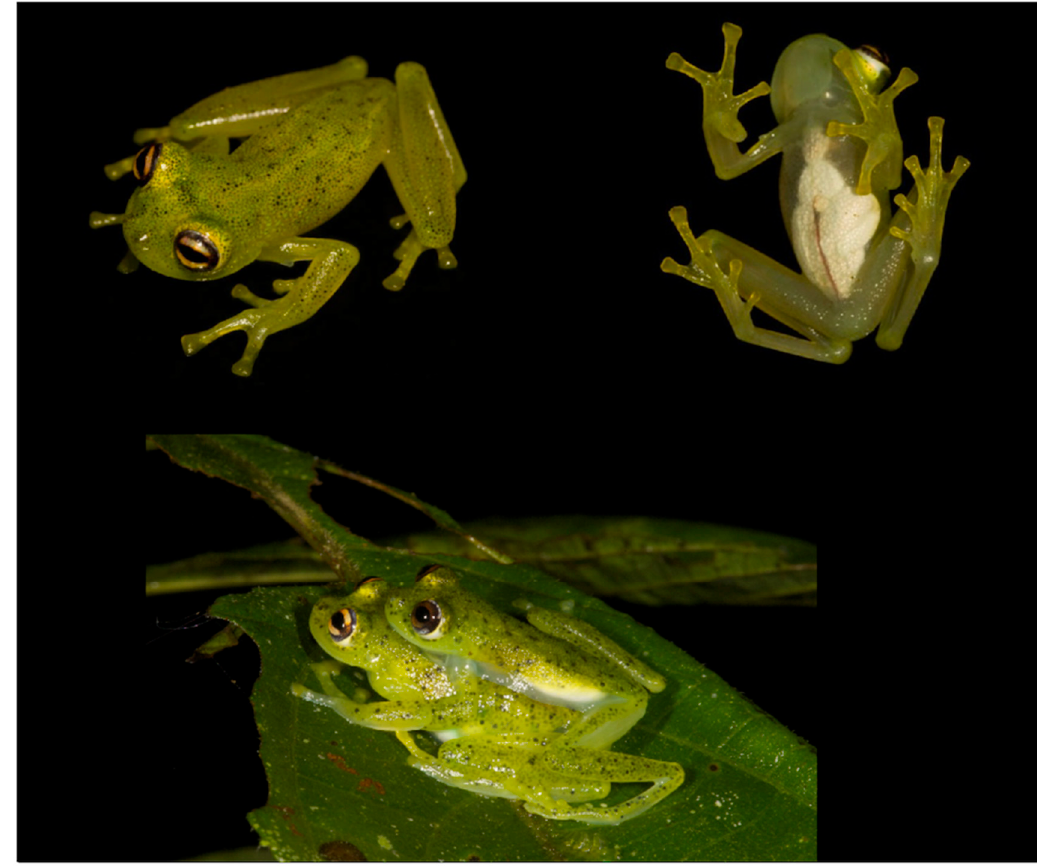
Figure 62. Chimerella mariaelenae in life. ( Top row ): Adult male from Bigal River Biological Station, 931 m, Ecuador; photos by Ross Maynard. ( Bottom row ): Amplectant pair, Quebrada Pangayaku, 930 m, Napo province, Ecuador, MZUTI 1680–81; photo by Eduardo Toral.